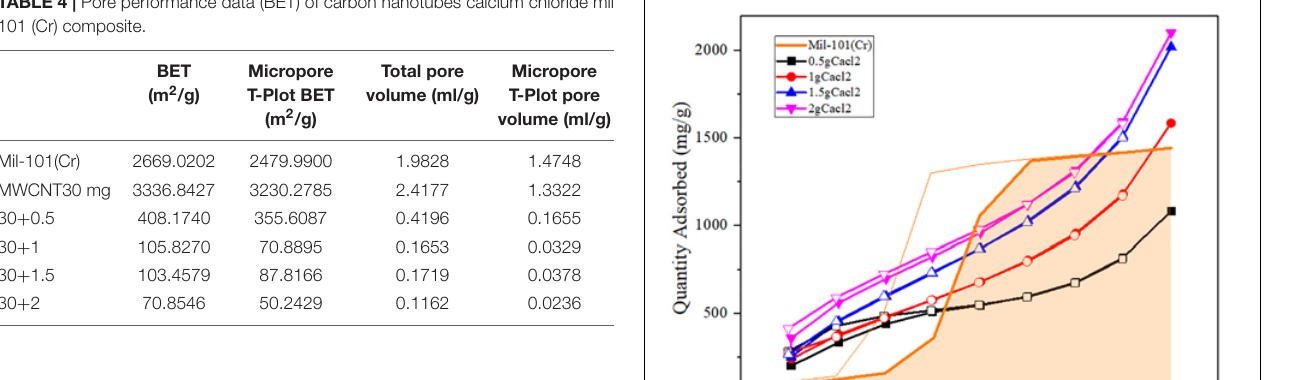
TABLE 4 | Pore performance data (BET) of carbon nanotubes calcium chloride mil 101 (Cr) composite.